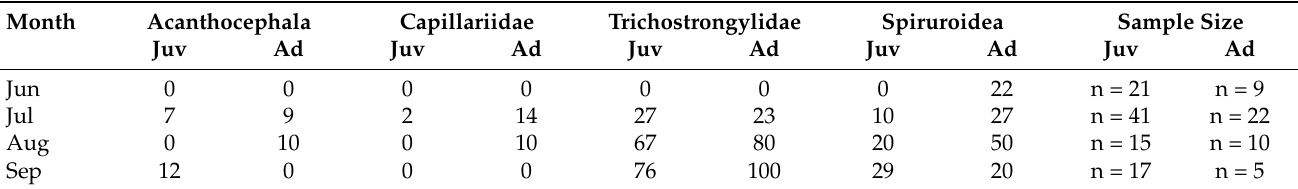
Table 5. Prevalence (%) of helminth taxa found in the coprological samples of resident and translo- cated ground squirrels. Juv = juveniles, Ad =